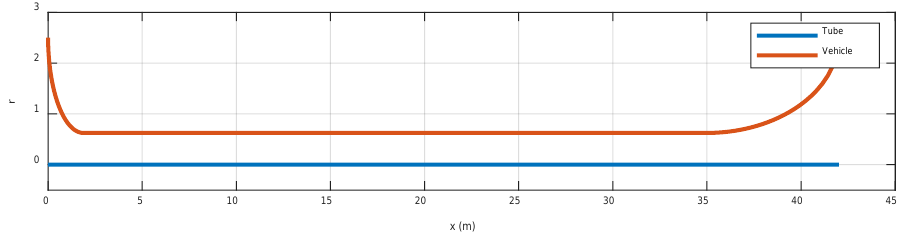
Figure 3. The modeled near-field domain.